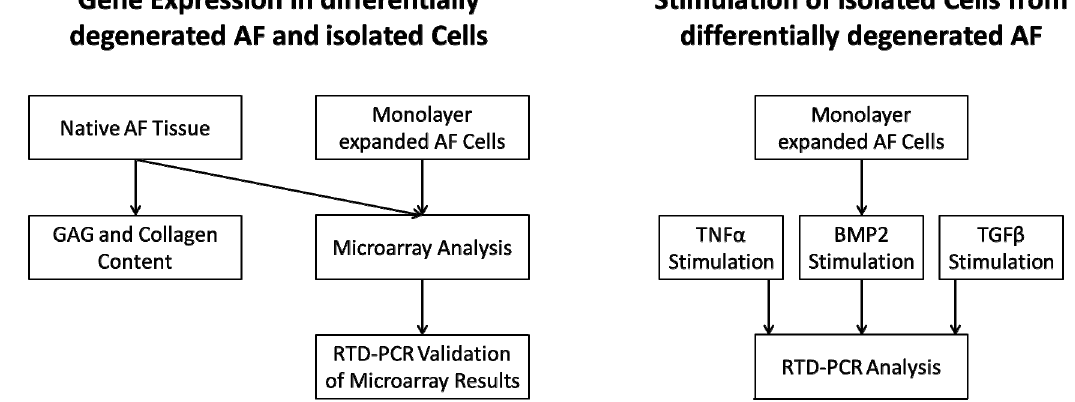
Figure 6. Experimental design for gene expression in differentially degenerated anulus fibrosus (AF) and isolated cells, and for the stimulation of isolated cells from differentially degenerated AF.